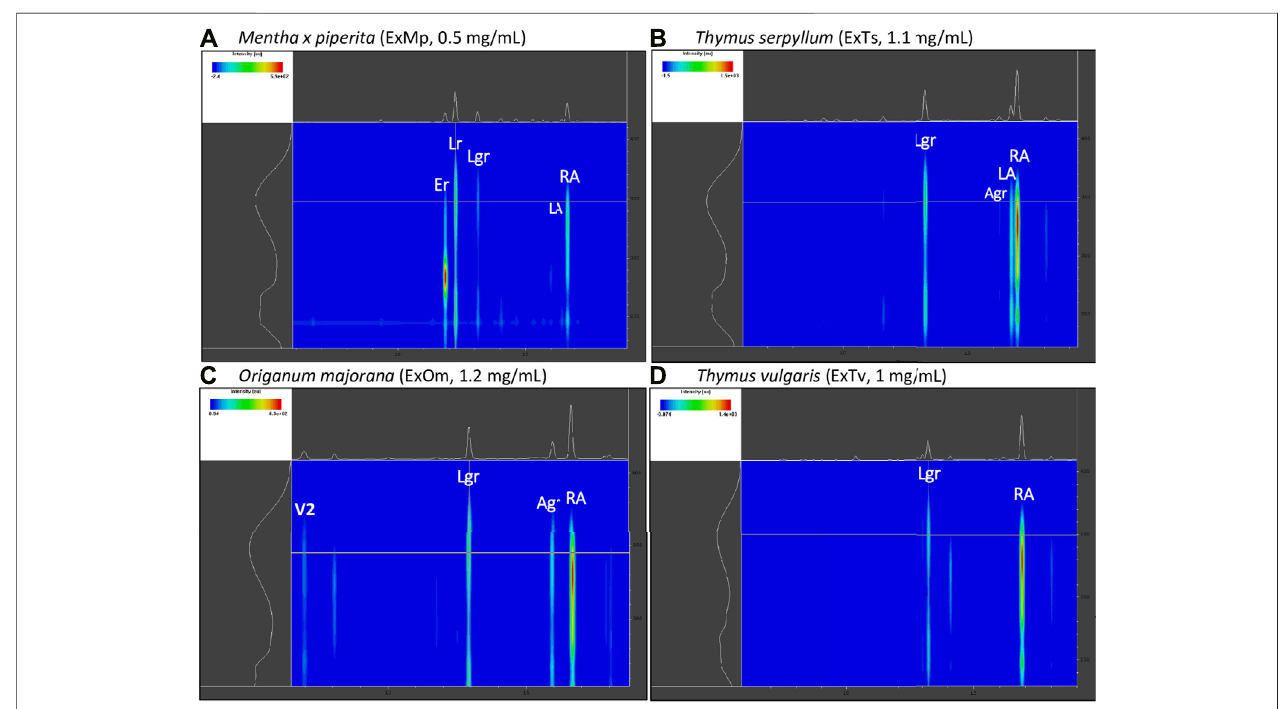
FIGURE 2 | Exemplary 2D HPLC-PDA chromatograms (range: 6 – 20 min/230-410 nm) of the analyzed extracts with the main polyphenols highlighted. (A) peppermint extract (ExMp); (B) wild thyme extract (ExTs); (C) origanum majorana extract (ExOm); (D) common thyme extract (ExTv).